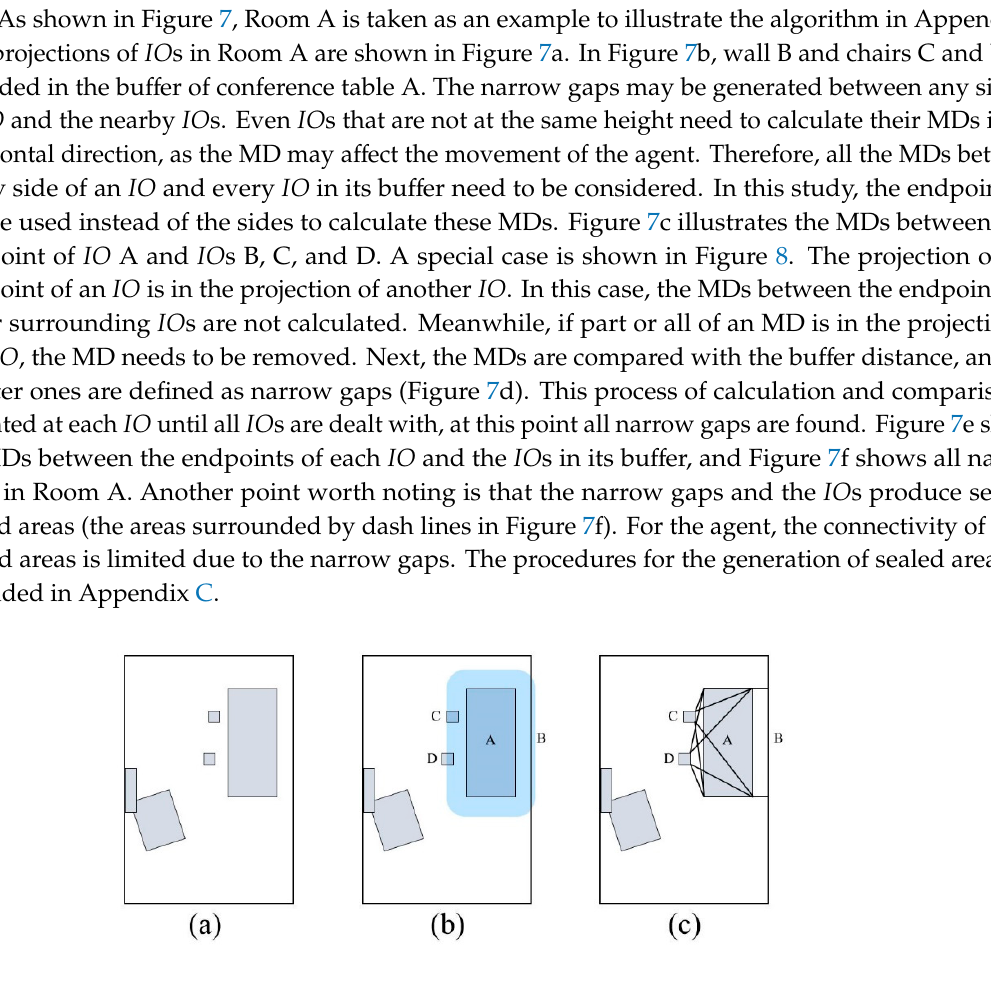
Figure 8. A special case that the projection of one endpoint of an 𝐼𝑂 is in the projection of another 𝐼𝑂 . Finally, CN-Space is generated by considering these obstacles and narrow gaps. In 3D space, the sides of 𝐼𝑂s and narrow gaps are regarded as impassable walls, and these impassable walls re-divide the indoor space in the vertical direction. Sealed areas are extended conceptually to sealed subspaces. A sealed subspace is formed with a sealed area as the bottom face (0 and 𝐻 (cid:3043)(cid:3045)(cid:3036)(cid:3049)(cid:3028)(cid:3047)(cid:3032) are set as its 𝐻 (cid:3031)(cid:3042)(cid:3050)(cid:3041) and 𝐻 (cid:3048)(cid:3043) respectively). The agent cannot move from one sealed subspace to another. Hence, considering the location of the agent, the subspace that the agent is in is selected as a reasonable navigable subspace. The other inaccessible sealed subspaces would be removed for the agent (Figure